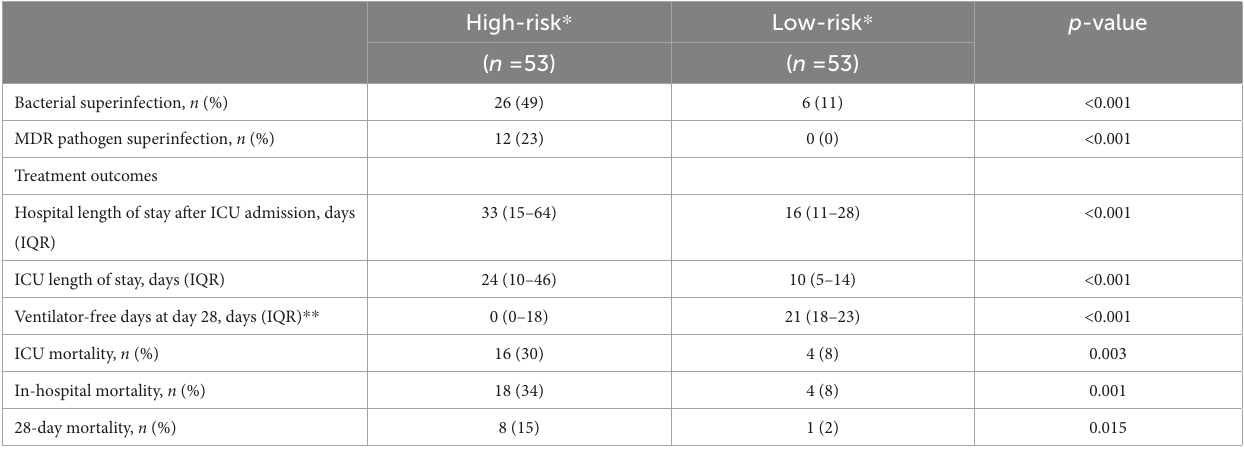
TABLE 5 Bacterial superinfection and clinical outcomes in critically ill patients with COVID-19 according to their SAPS II score and platelet count. High-risk